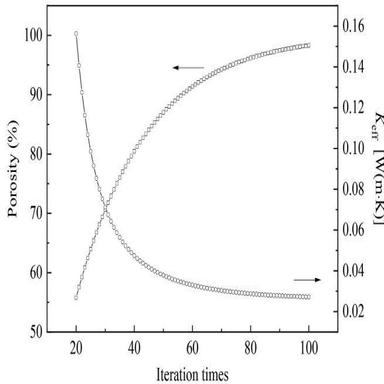
The relationship between the iteration times and porosity and thermal conductivity of MFs fractal model.